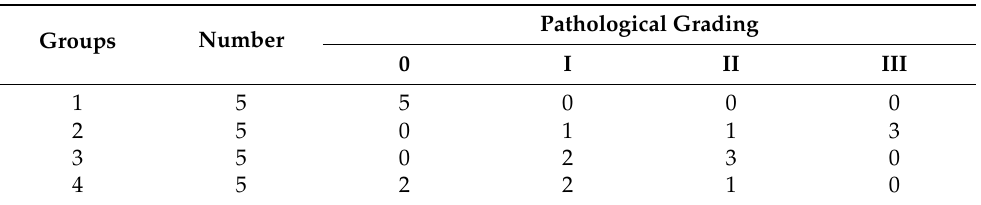
Table 5. Effect of chemical and natural iron oxide nanoparticles on the pathological grading of lead toxicity in hepatic tissue of different treated groups.